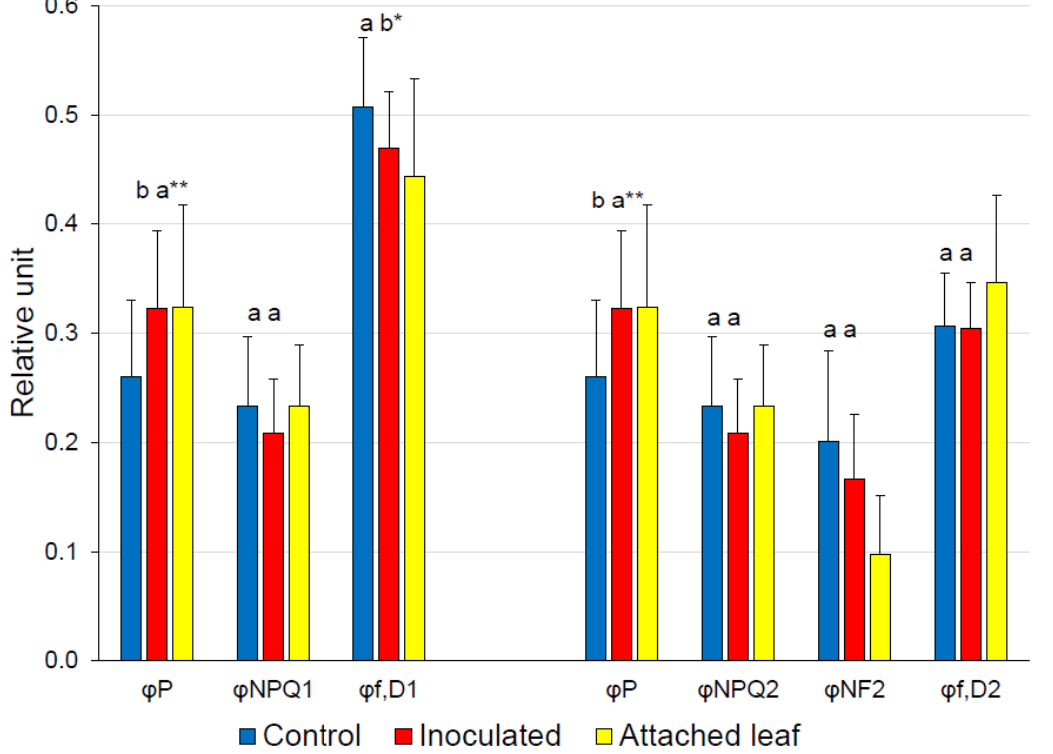
Figure 2. Energy partitioning of detached control tobacco leaves infiltrated with demineralized wa-